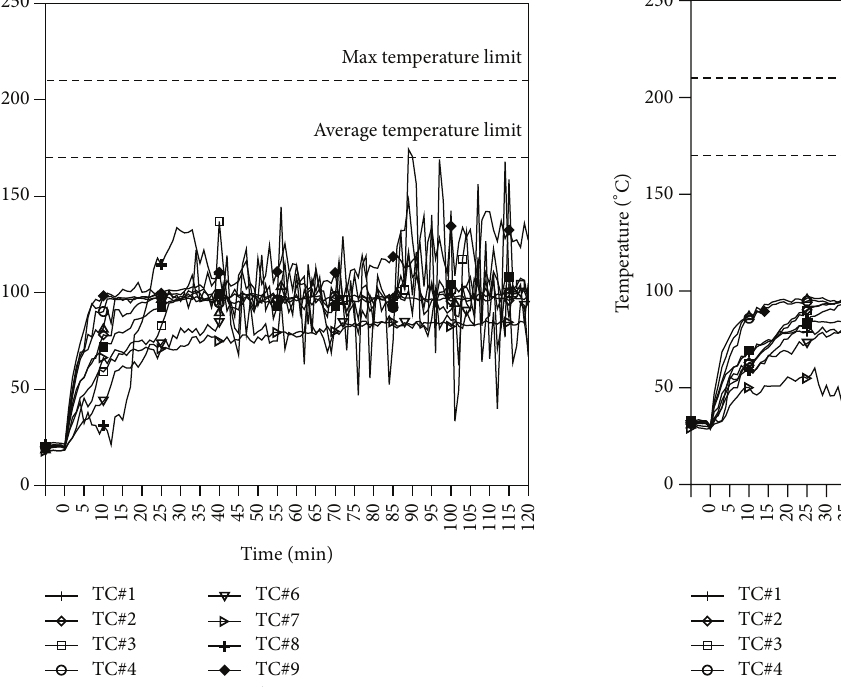
Figure 12: Temperature distributions of the unexposed surface (water film on the exposed